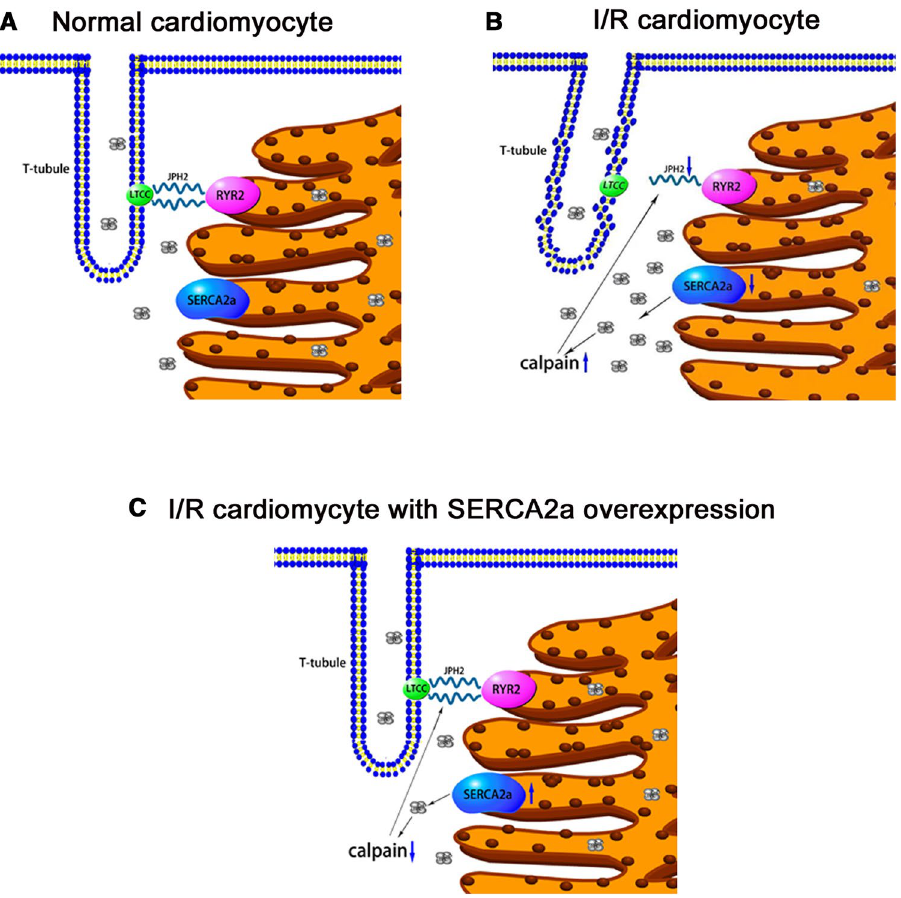
Figure 6. Scheme summarizing the potential mechanism of SERCA2a ameliorating cardiac function via calpain/JPH2/T-tubule in myocardial I/R mice. The image was created using Pathway Builder Tool 2.0(www. prote inlou